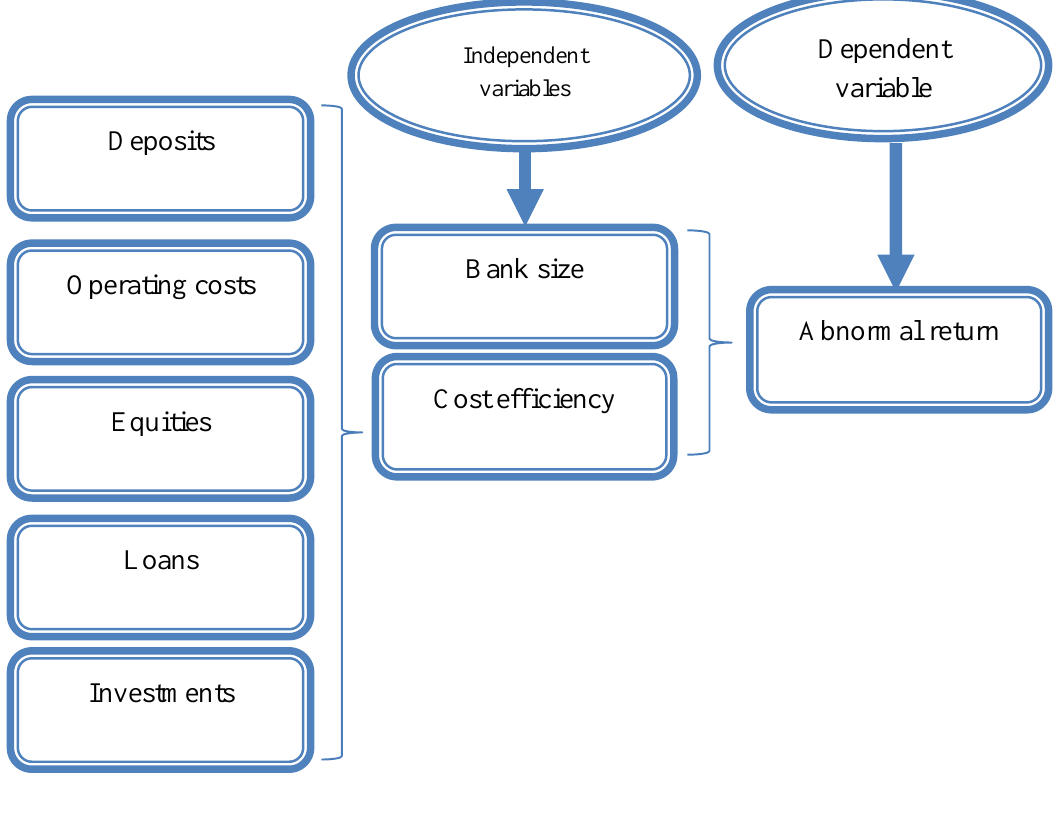
Fig. 1. The structure of the proposed